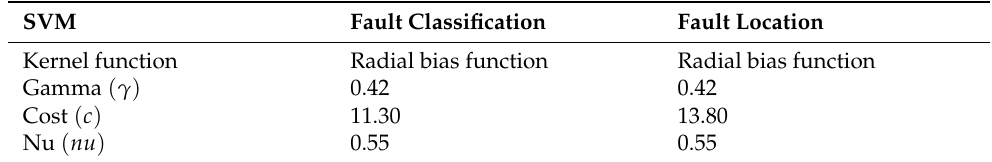
Table 5. Feature selection of SVM using PSO.